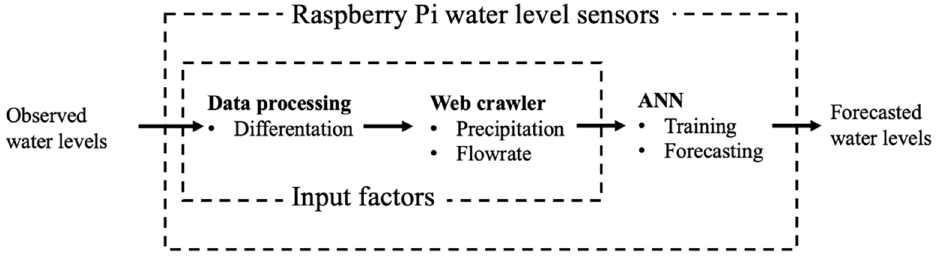
Figure 2. System data processing flowchart.